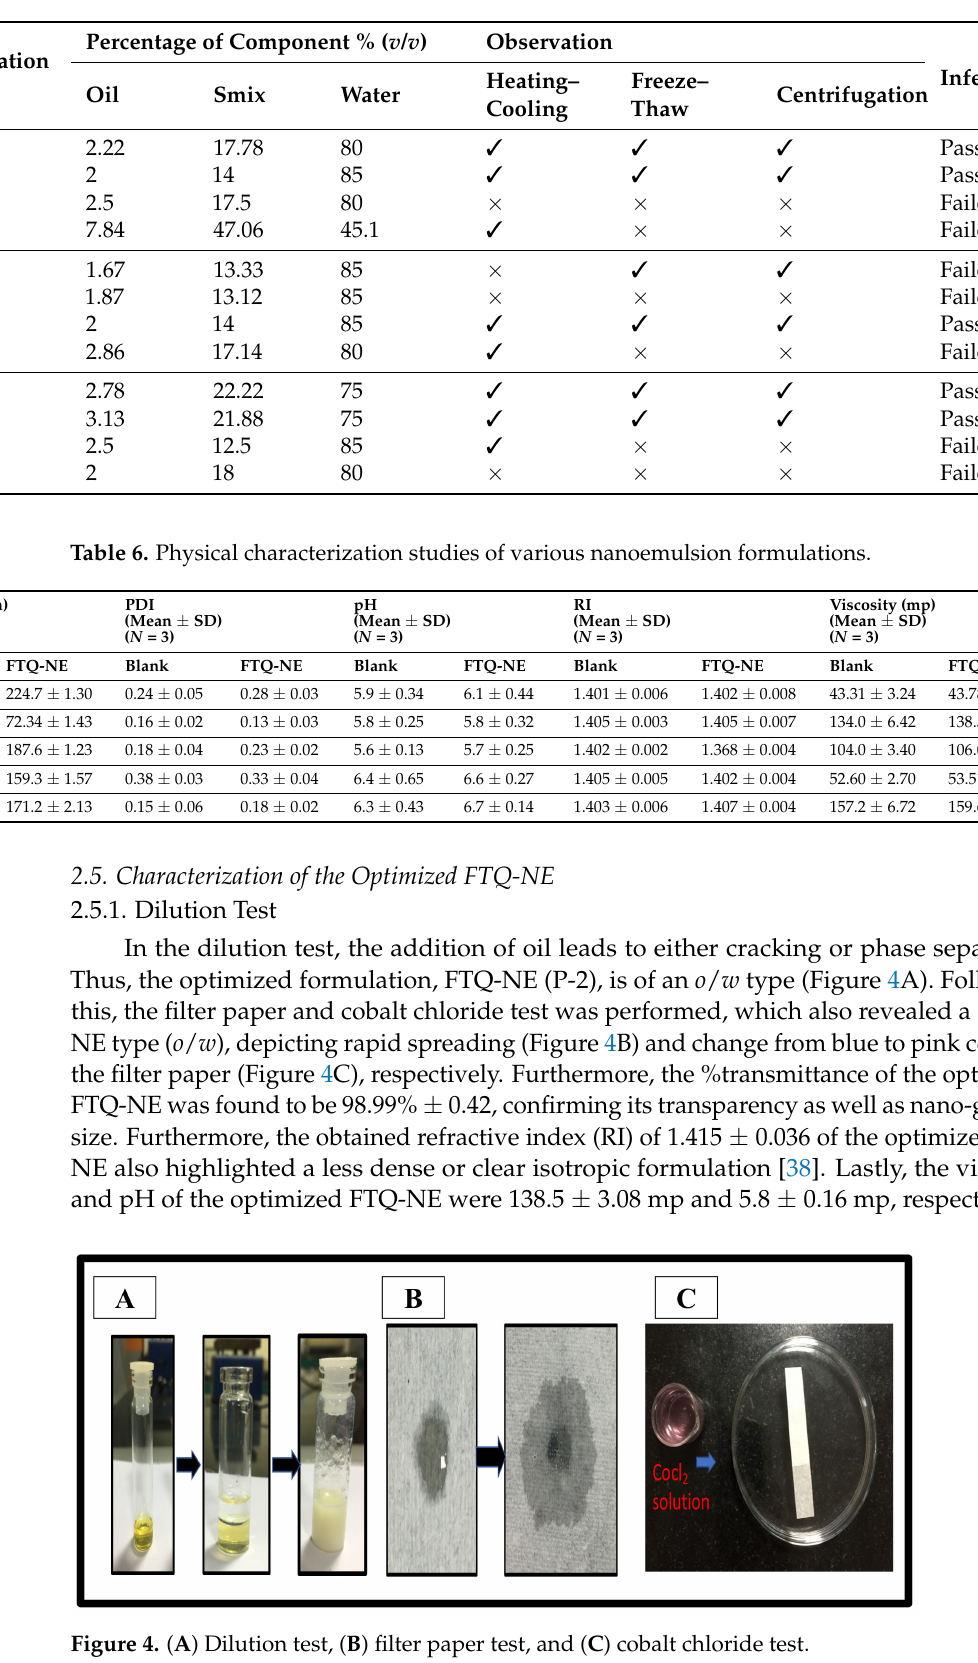
Table 5. Thermodynamic stability testing of the selected nanoemulsion formulations using heating–